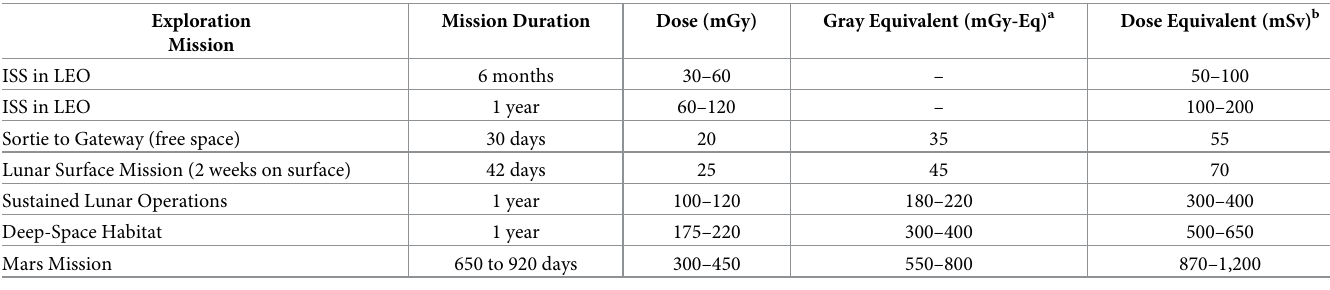
Table 1. Summary of exploration mission